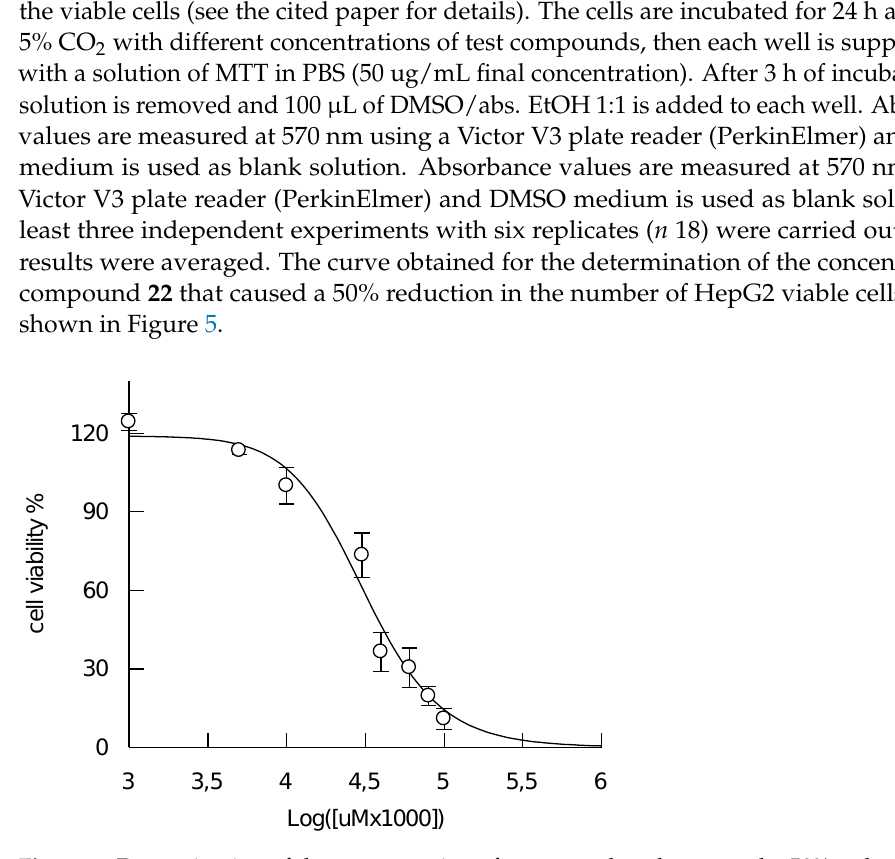
Figure 5. Determination of the concentration of compound 22 that caused a 50% reduction in the number of HepG2 viable cells (IC 50 ).